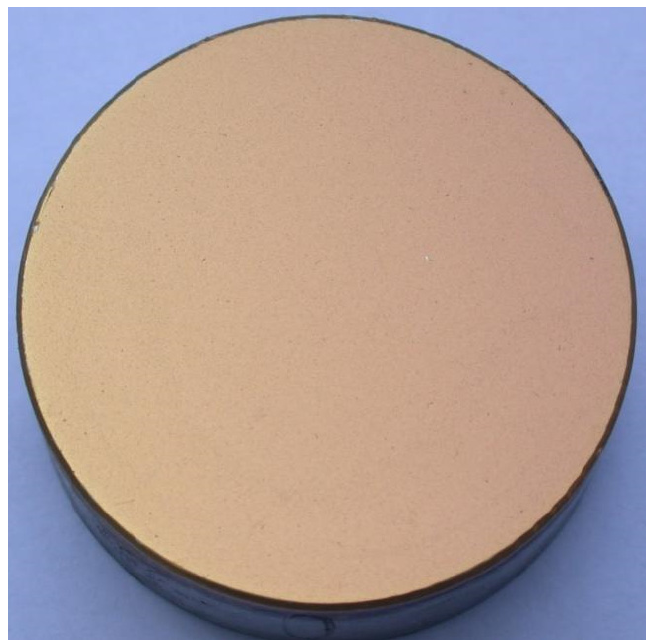
Figure 3. The photograph of ion-assisted arc deposition ZrN coating sample.